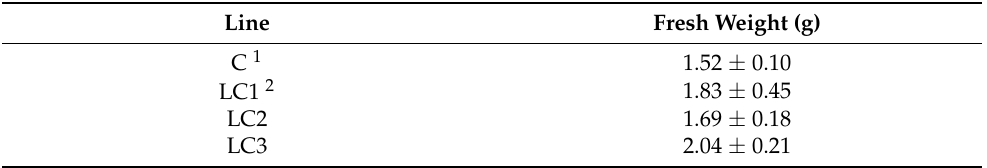
Table 1. Fresh weight (g) of GUS - and ZmLC -overexpressing hairy root lines cultured at 25 °C in continuous darkness for two weeks.